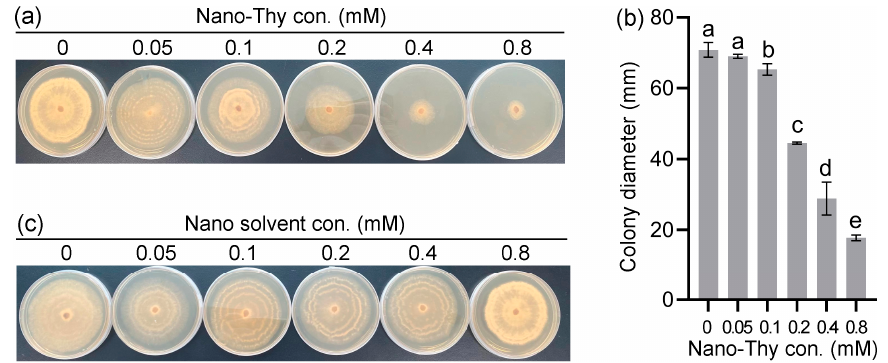
Figure 4. The effect of Nano-Thy on mycelial growth of B. cinerea . ( a ) The growth of B. cinerea in PDA with different concentrations of Nano-Thy for 72 h. ( b ) The colony diameter measured from ( a ). Different lowercase letters indicated significant difference among treatments (ANOVA, n = 3, p < 0.05). ( c ) The growth of B. cinerea in PDA with different concentrations of Nano solvent.